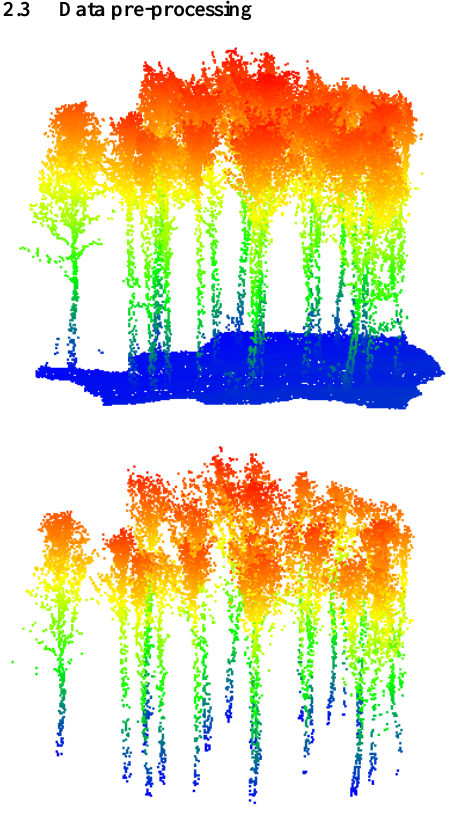
Figure 2. Plot B (Sycamore), top – before pre-processing, bottom – after